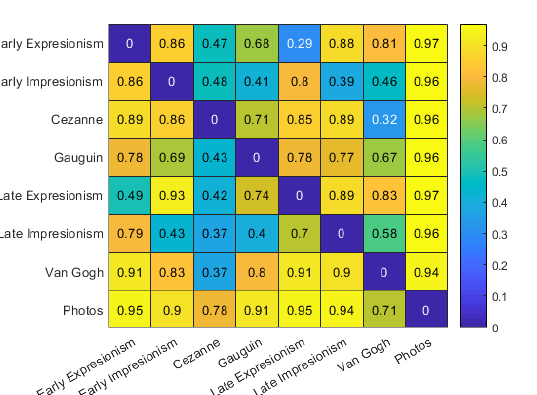
Figure 7. Effective reaction times between styles. Row labels denote the identity of the target stimulus, column labels denote the identity of the distractor stimulus.